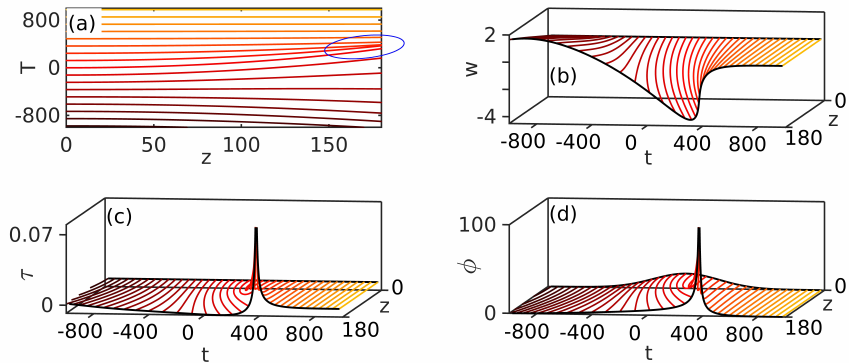
Figure 3. Numerical integration of the coupled system of characteristic ODE (5)–(9): ( a ) Characteristics T ( z ) for a set of initial conditions T ( 0 ) = t 0 . Corresponding evolutions of the momentum (chirp) w ( z ) ( b ) that exhibits a shock singularity, i.e., a collapse singularity for the corresponding gradient τ ( z ) ( c ), which in turn induces a collapse singularity for the envelope of the incoherent pulse φ ( z ) ( d ) ( σ = − 1, τ R = 300).